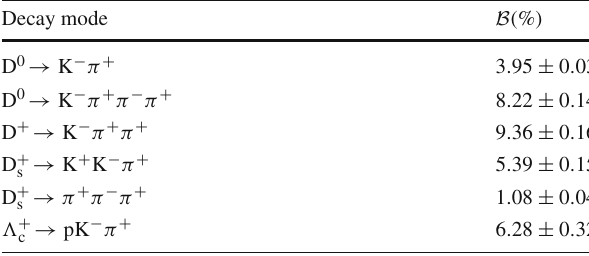
Table7 Branchingfractionsofexperimentallyefficientdecaychannels for different charm hadron species from Ref.